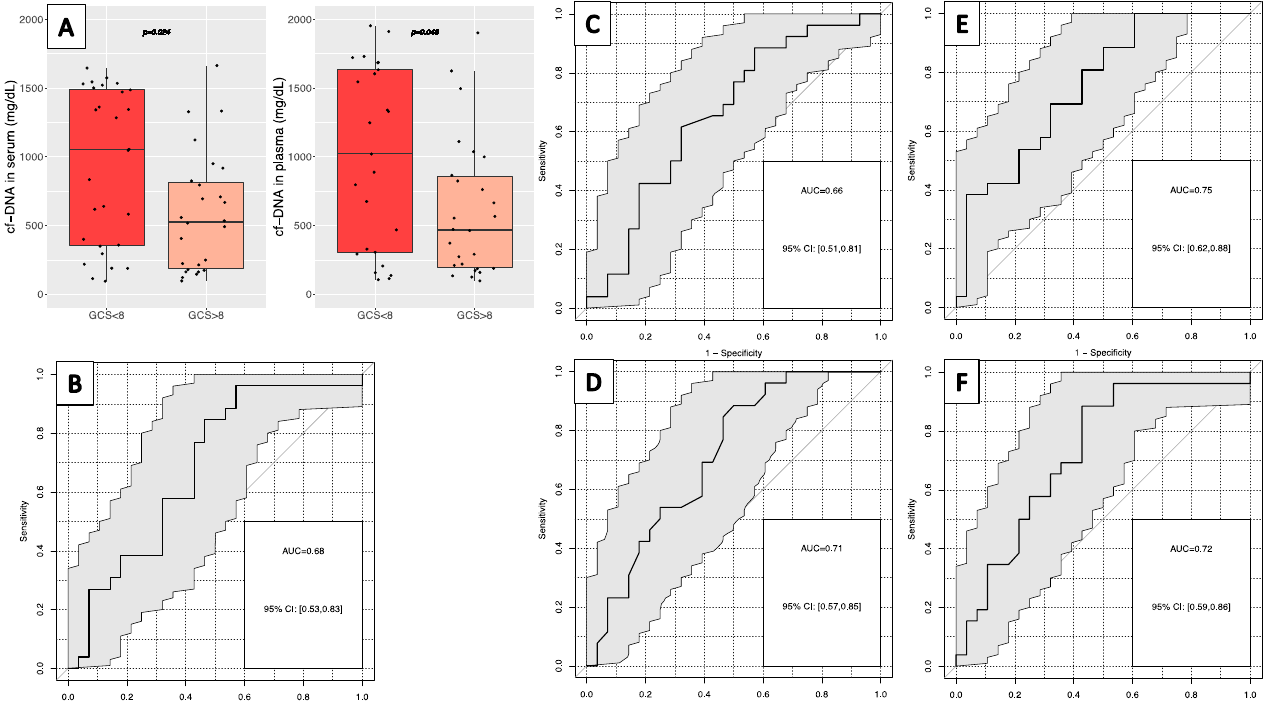
Figure 7. ( A ) Distribution of cfDNA levels in serum and plasma for severe traumatic brain injury (GCS ≤ 8) or mild/moderate brain injury (GCS > 8). Receiver operating characteristic curve for the discrimination of severity of traumatic brain injury for: ( B ) cfDNA in serum; ( C ) cfDNA in plasma; ( D ) hemoglobin; ( E ) cfDNA in serum, hemoglobin and leukocytes for the discrimination of severity of traumatic brain injury; ( F ) random forest model for traumatic brain injury severity.